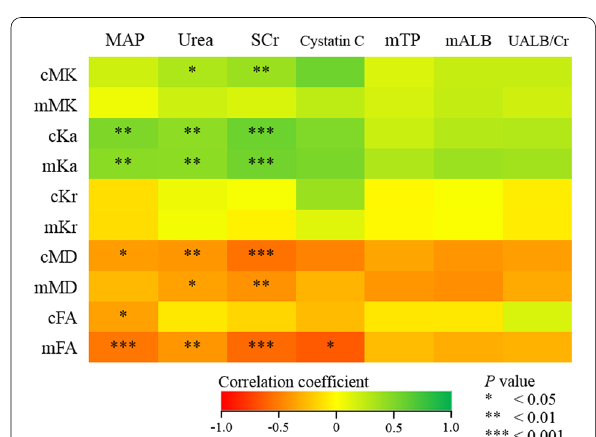
Fig. 5 Heatmap of correlations between the clinicopathological characteristics of patients and DKI metrics of renal cortex (c) and medulla (m). DKI, diffusion kurtosis imaging; MAP, mean arterial blood pressure; SCr, serum creatinine; mTP, urinary total microprotein; mALB, urinary microalbumin; UALB/Cr, urinary